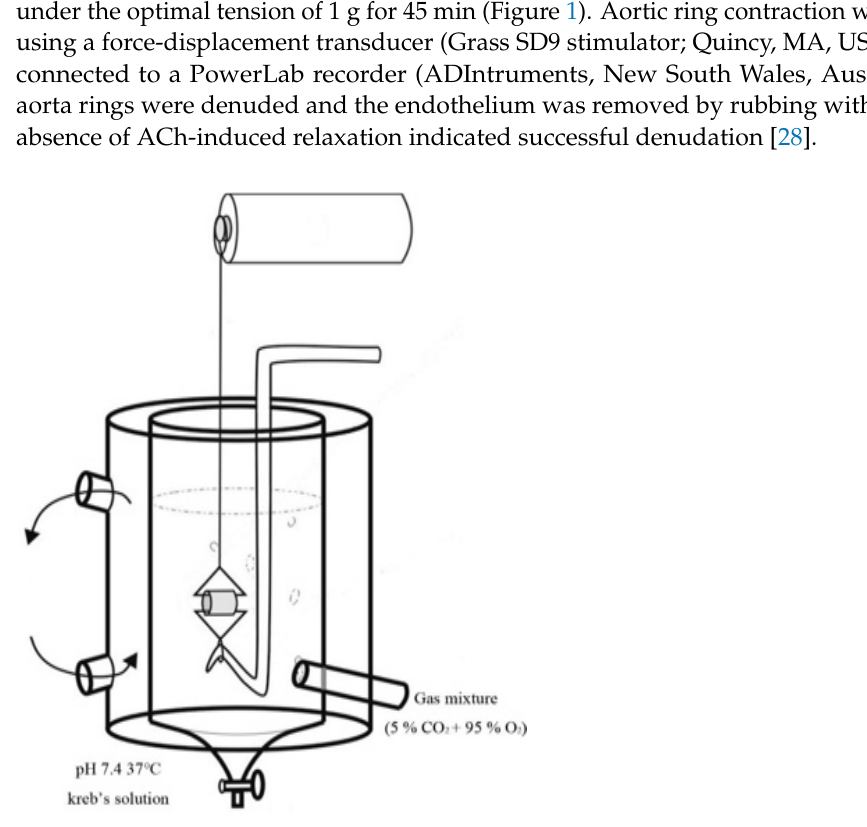
Figure 1. Rat aortic ring in an organ bath.